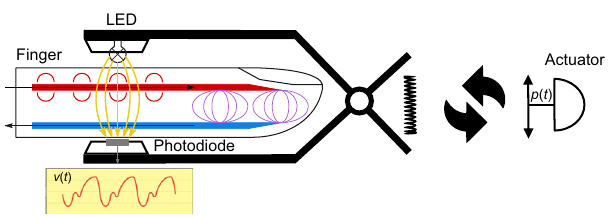
Fig. 1 Actuator within CNAP2GO. Within CNAP2GO, the element for constant pressure coupling is a simple, slow-moving actuator that can vary the contact pressure p(t) of the light elements (light-emitting diode and photodiode) as fast as mean blood pressure may change. v(t) :